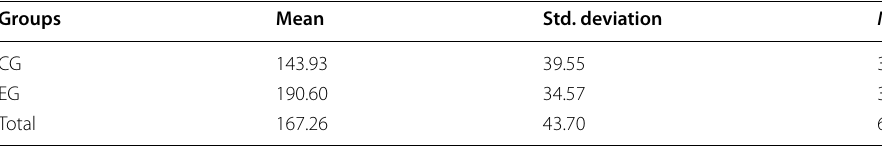
Table 5 EG and CG (RM post-tests)